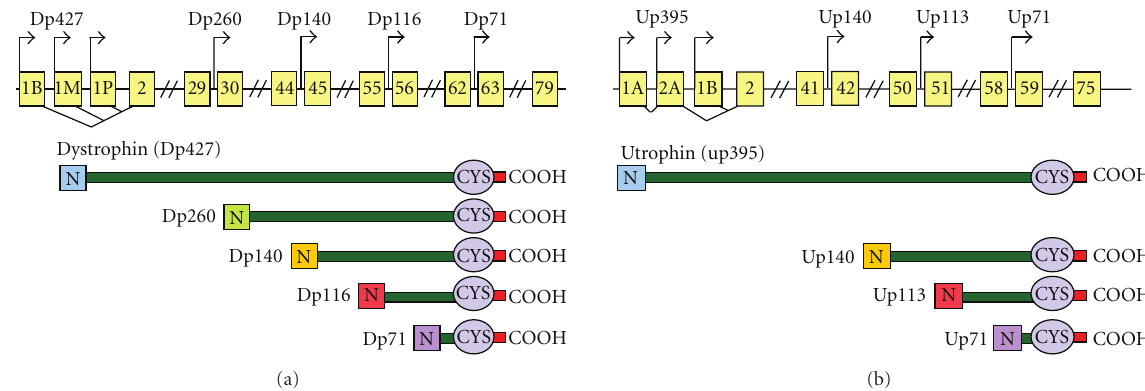
Figure 1: Organization of the human dystrophin (a) and utrophin (b) genes and corresponding protein products. Top panels show specific exons (yellow boxes with exon numbers) and intronic regions (black line) flanking transcription start sites of the di ff erent gene internal promoters (arrows) (Source: Pubmed: ENSG00000198947 for DMD gene; ENSG00000152818 for utrophin gene). Alternatively spliced first exons giving rise to distinct full-length forms of dystrophin (B: Brain; M: Muscle; P: Purkinje cells) and utrophin (Utrn-A; Utrn-B) are depicted (adapted from [30]). The di ff erent dystrophin (a) and utrophin-gene (b) protein products derived from distinct internal promoters are shown below the corresponding genes, as indicated. The main structural domains are represented, including the specific NH2-terminus domain (N, di ff erent colors schematize distinct NH2-terminal sequences), the central rod domain (green bar), the cysteine-rich domain (CYS, blue), and the COOH-terminus (red). All gene regions and protein domains are not to